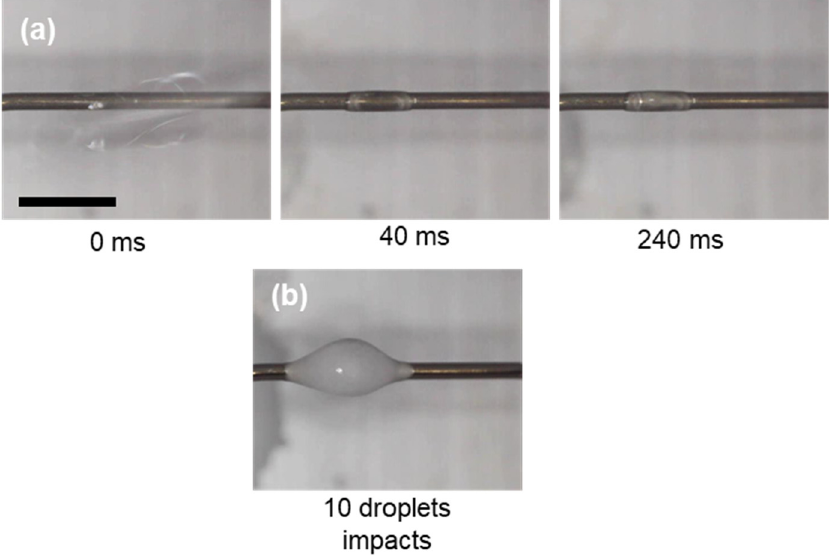
Figure 6. Freezing process of impacting droplets of 15 µL at 1.5 m/s ( We = 94) on the hydrophilic wire at − 20 °C. ( a ) Sequential images of the freezing process of the first droplet on the wire. ( b ) The ice accretion after 10 consecutive droplets impacting on the wire every 1 min. Scale bar is 3 mm.